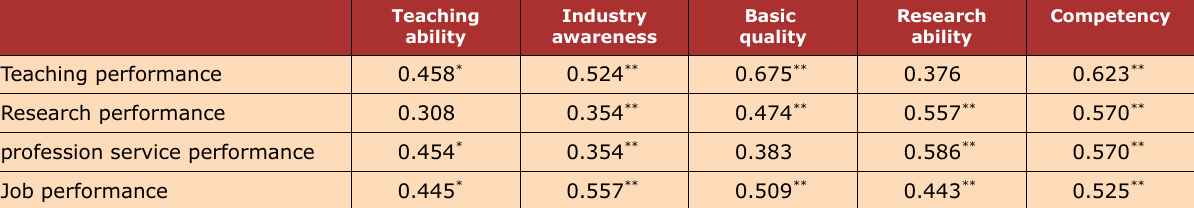
Table 1. Correlation analysis between competency and job performance